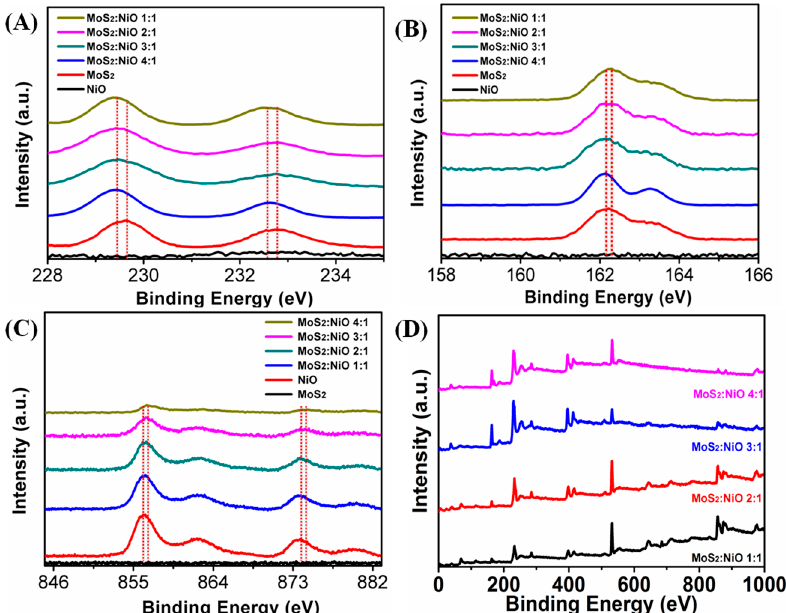
Figure 2. XPS spectra of MoS 2 :NiO catalysts ( D ) in the Mo 3d ( A ), S 2p ( B ) and Ni 2p ( C ) spectral regions.